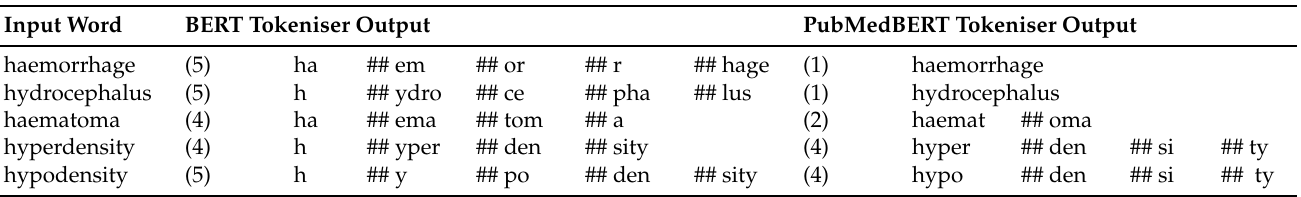
Table 6. Comparison of tokeniser output for original BERT and PubMedBERT. We show the number of tokens in brackets, followed by the tokens separated by the conventional ## symbol.